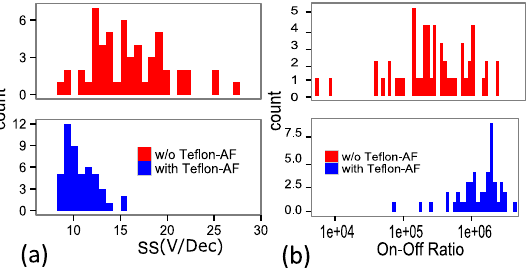
Figure 6. Histogram distribution of ( a ) subthreshold swing; and ( b ) On ‐ Off ratio of 60 measured devices before and after applying Teflon ‐ AF cap presented in a log ‐ scale x ‐ axis.